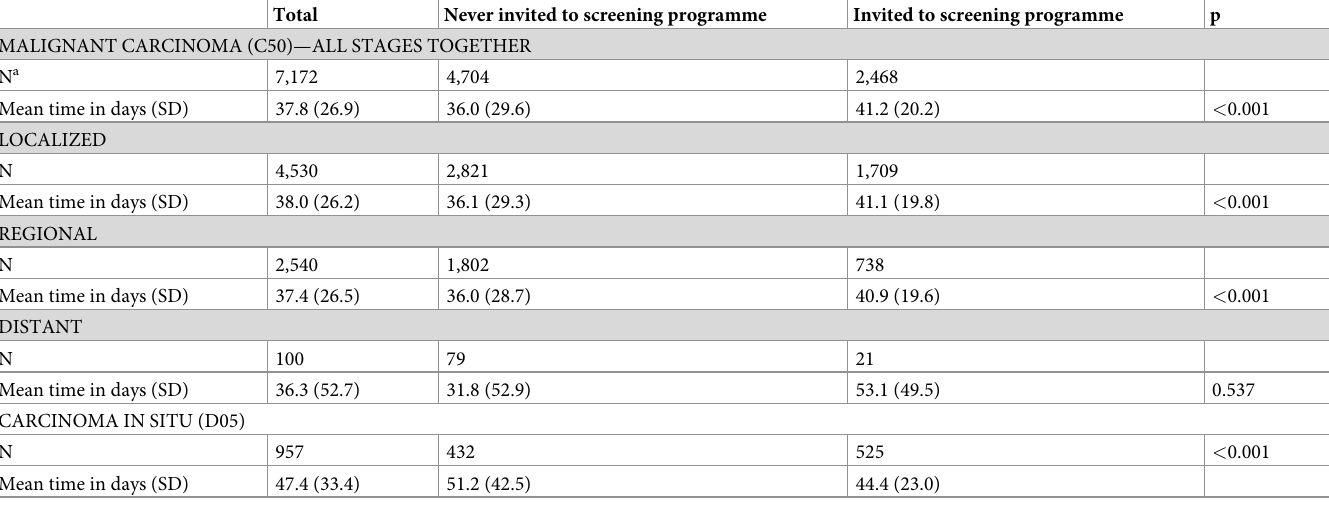
Table 2. Time from diagnosis of breast cancer to surgery as first treatment (number of cases in each group (N) and mean time in days with standard deviation (SD)) in women aged 50–74 years, by stage at diagnosis and availability of organised screening programme, Slovenia, 2008–2018. Total Never invited to screening programme Invited to screening programme MALIGNANT CARCINOMA (C50)—ALL STAGES